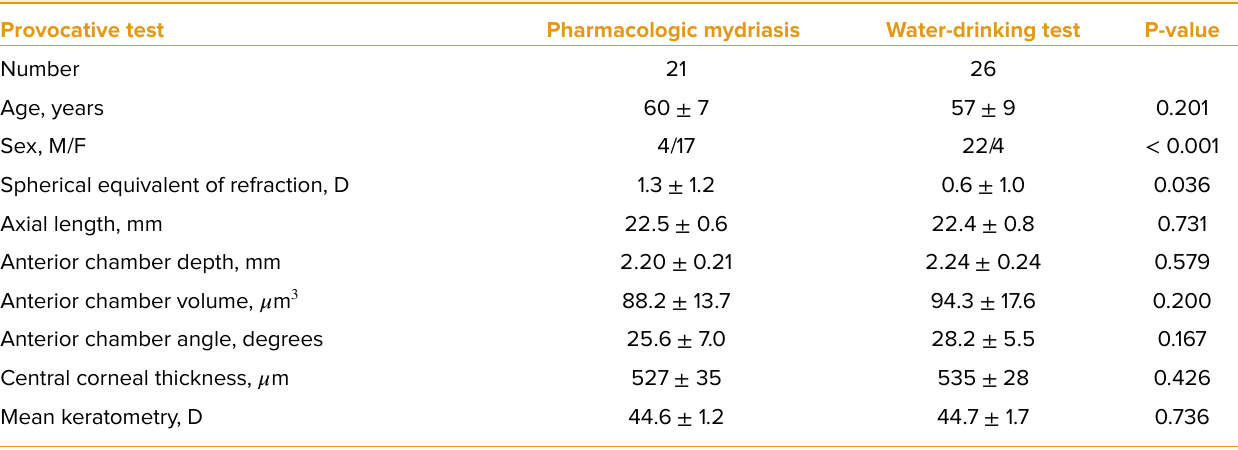
Table 1. Baseline characteristics of patients suspected of primary angle closure that underwent provocative testing with either the pharmacologic mydriasis or water-drinking test Provocative test